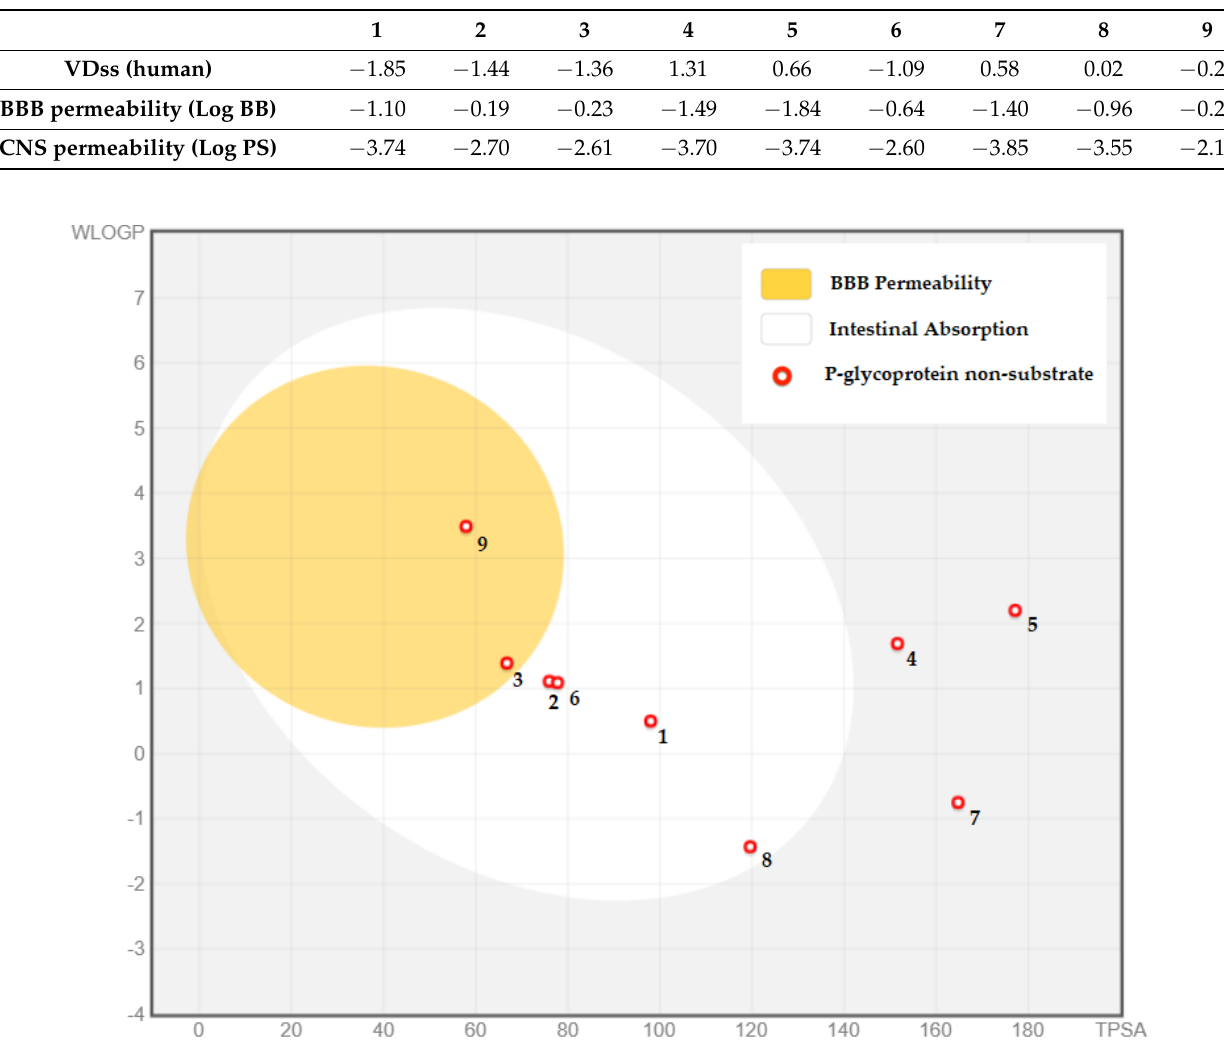
Table 4. Distribution characteristics prediction of A. halimus leaf ethanolic extract. ( 1 ) Gallic acid, ( 2 ) syringic acid, ( 3 ) trans -ferulic acid, ( 4 ) myricetin, ( 5 ) catechin gallate, ( 6 ) caffeic acid, ( 7 ) chlorogenic